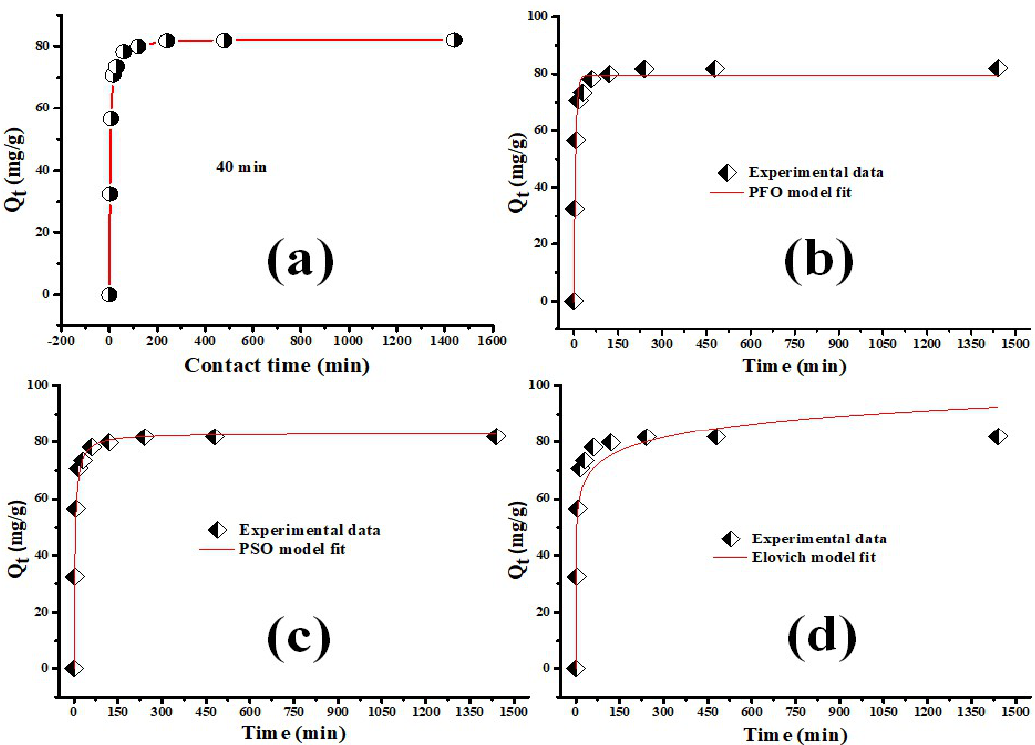
Figure 5. ( a ) The contact time study, ( b – d ) kinetic investigation of RhB sorption on MgTiO 3 @g-C 3 N 4 nanohybrid via the pseudo-first-order model, pseudo-second-order model, and Elovich model, respectively. Table 1. Kinetic model parameters for the adsorption of RhB dye by nanocomposite. Pseudo-First-Order